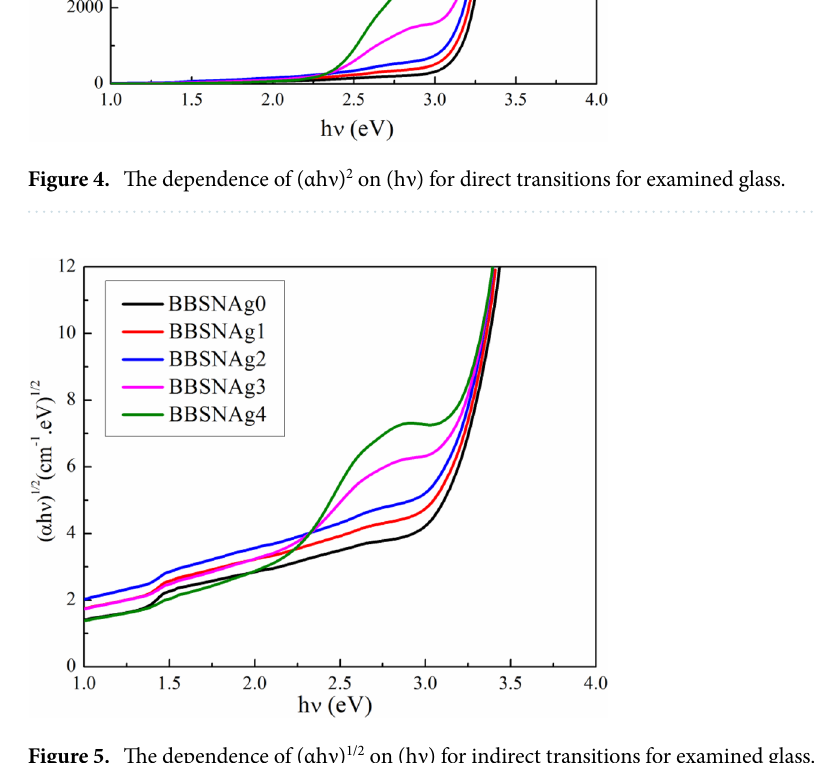
Figure 5. The dependence of (αhν) 1/2 on (hν) for indirect transitions for examined